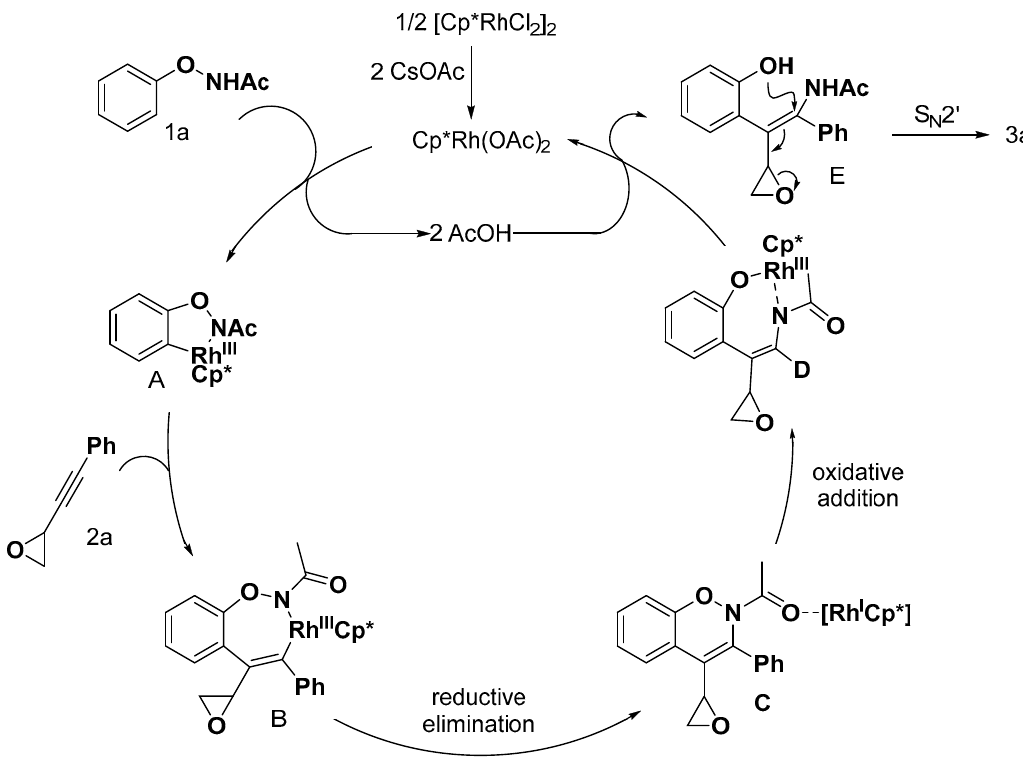
Scheme 5. Rh(III)-catalyzed synthesis of benzofuran-2(3 H )-ones.